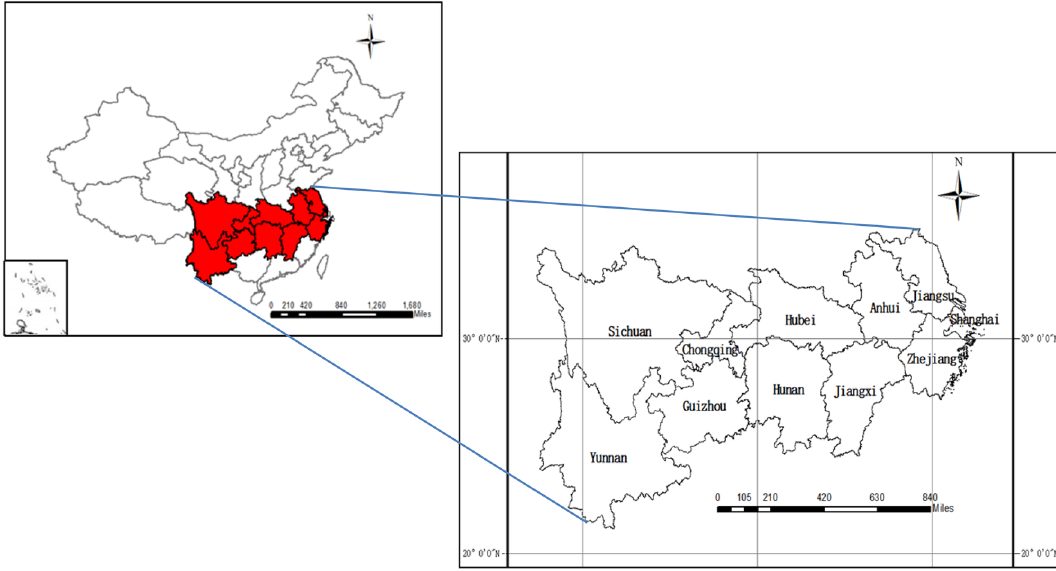
Figure 1. Location of the YREB, China. The map was generated by ArcGIS 10.5. https ://www.esri.com/en-us/ arcgi s/produ cts/distr ictin g-for-arcgi s/overv